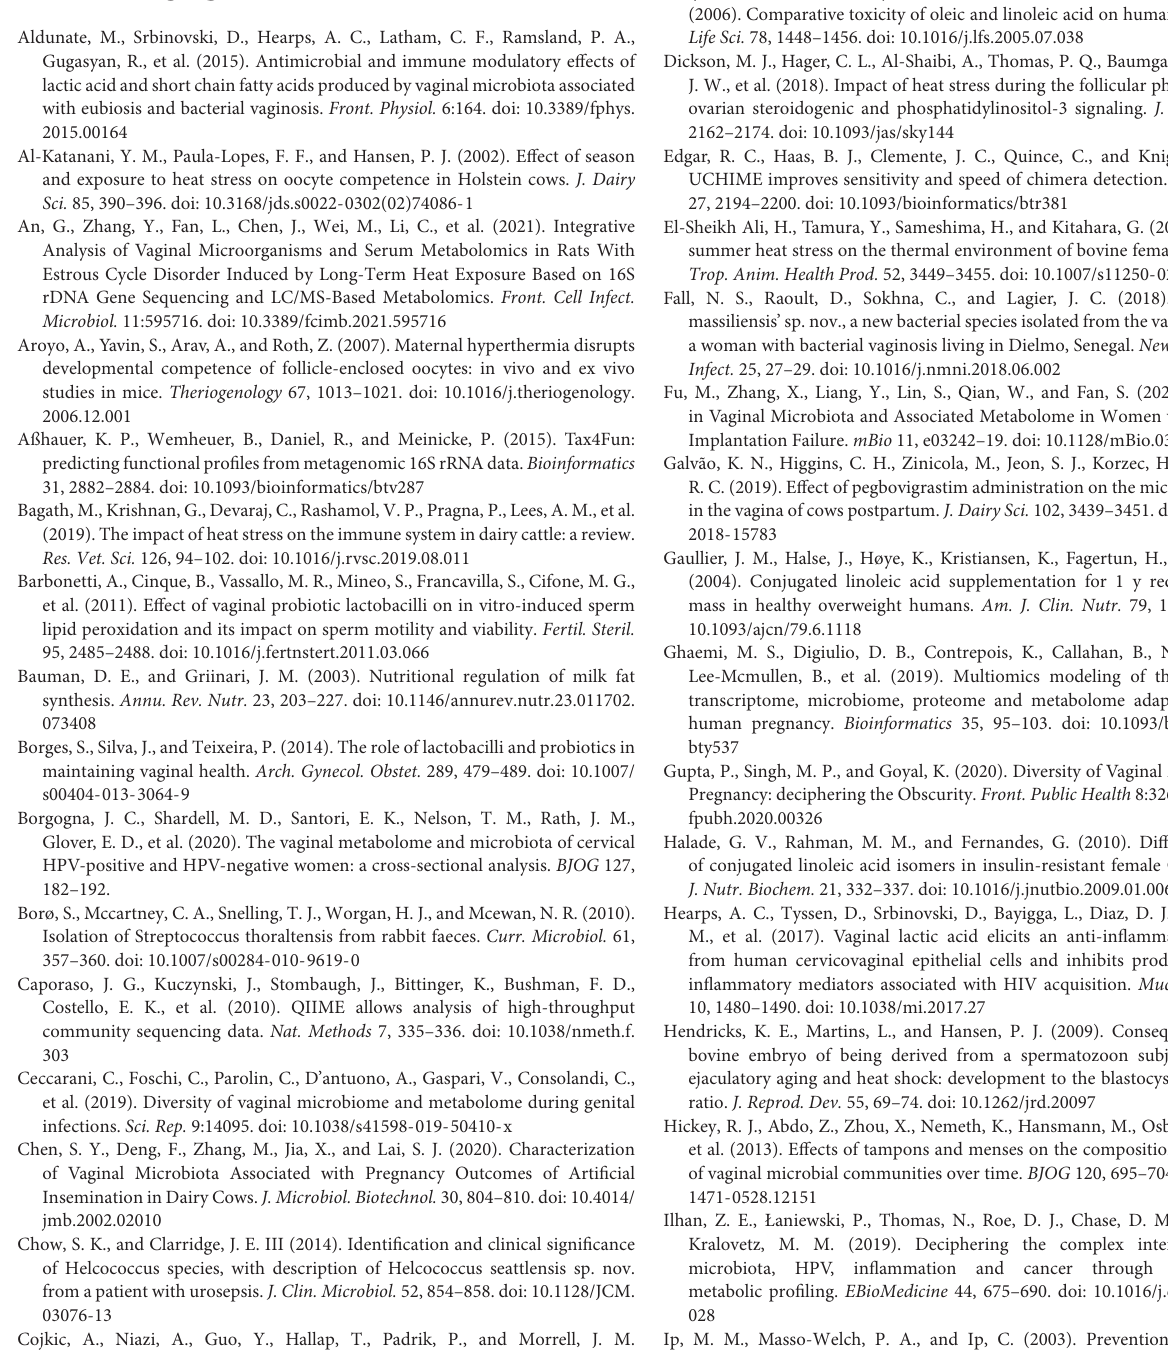
Supplementary Figure 1 | The annotations of all identified metabolites using the database HMDB (A) and LIPID (B) and KEGG (C) database. The histogram indicates the number of metabolites in the category. Supplementary Table 1 | The relative abundance of the top 10 abundant microbiota at the genus level for each individual rabbit. HS1–HS8 indicate the